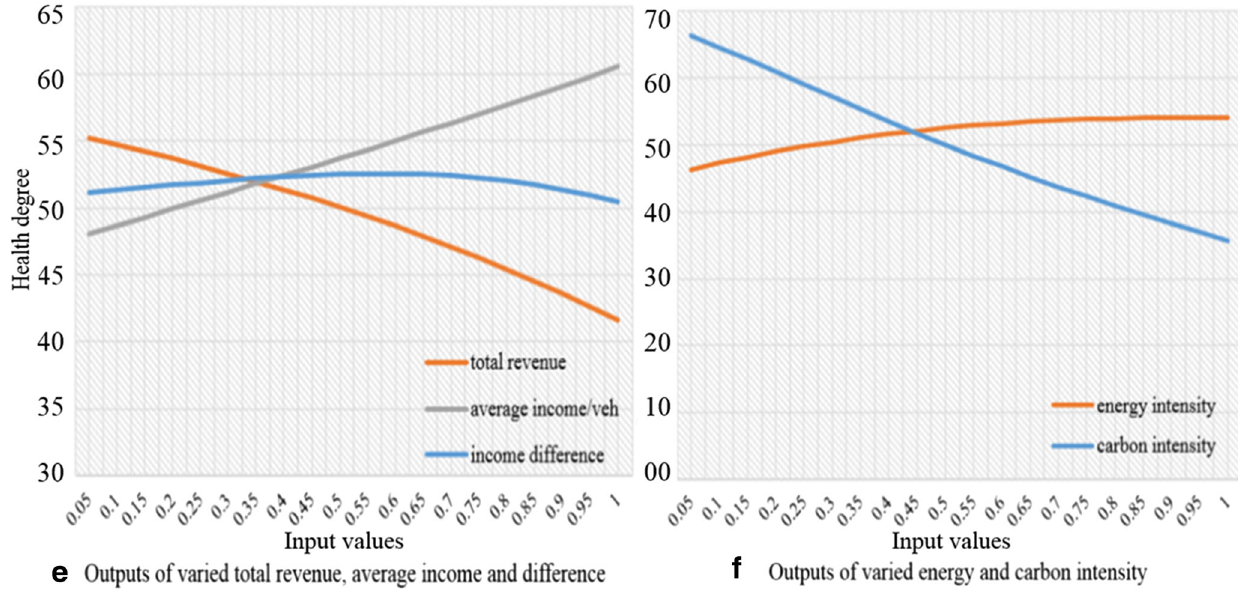
Fig. 11 Outputs of varied input of